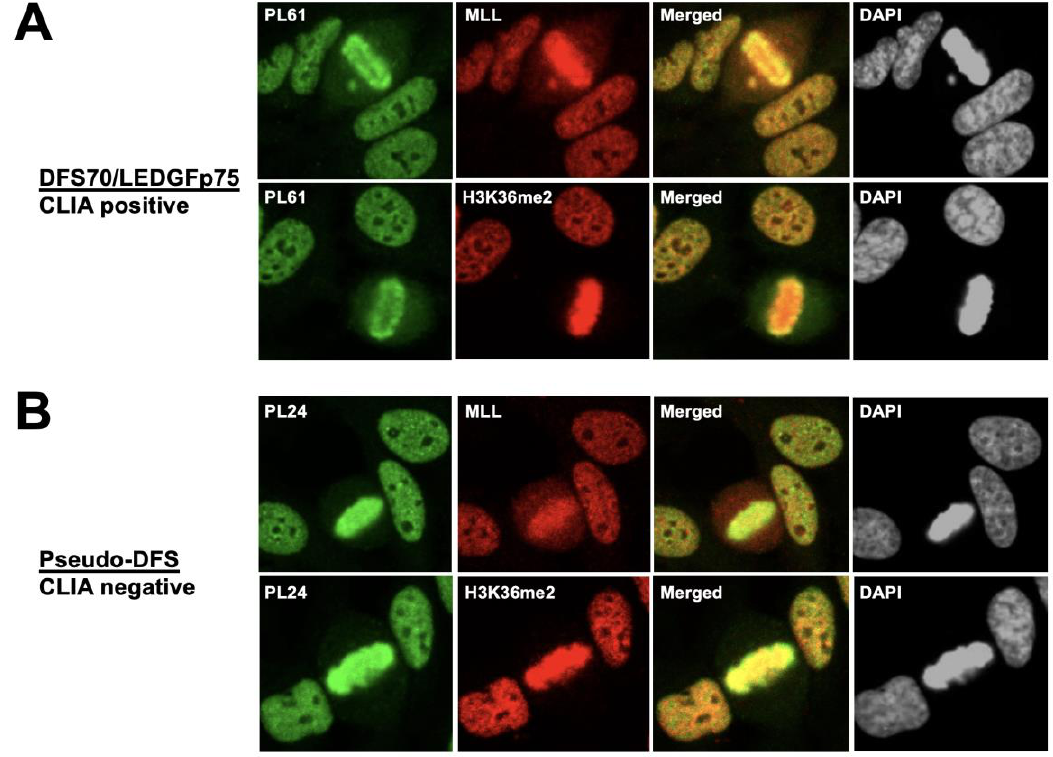
Figure 8. Co-localization of monospecific CLIA anti-DFS70-positive and anti-DFS70-negative autoantibodies with anti-MLL and anti-H3K36me2 antibodies. ( A ) CLIA anti-DFS70-positive anti-